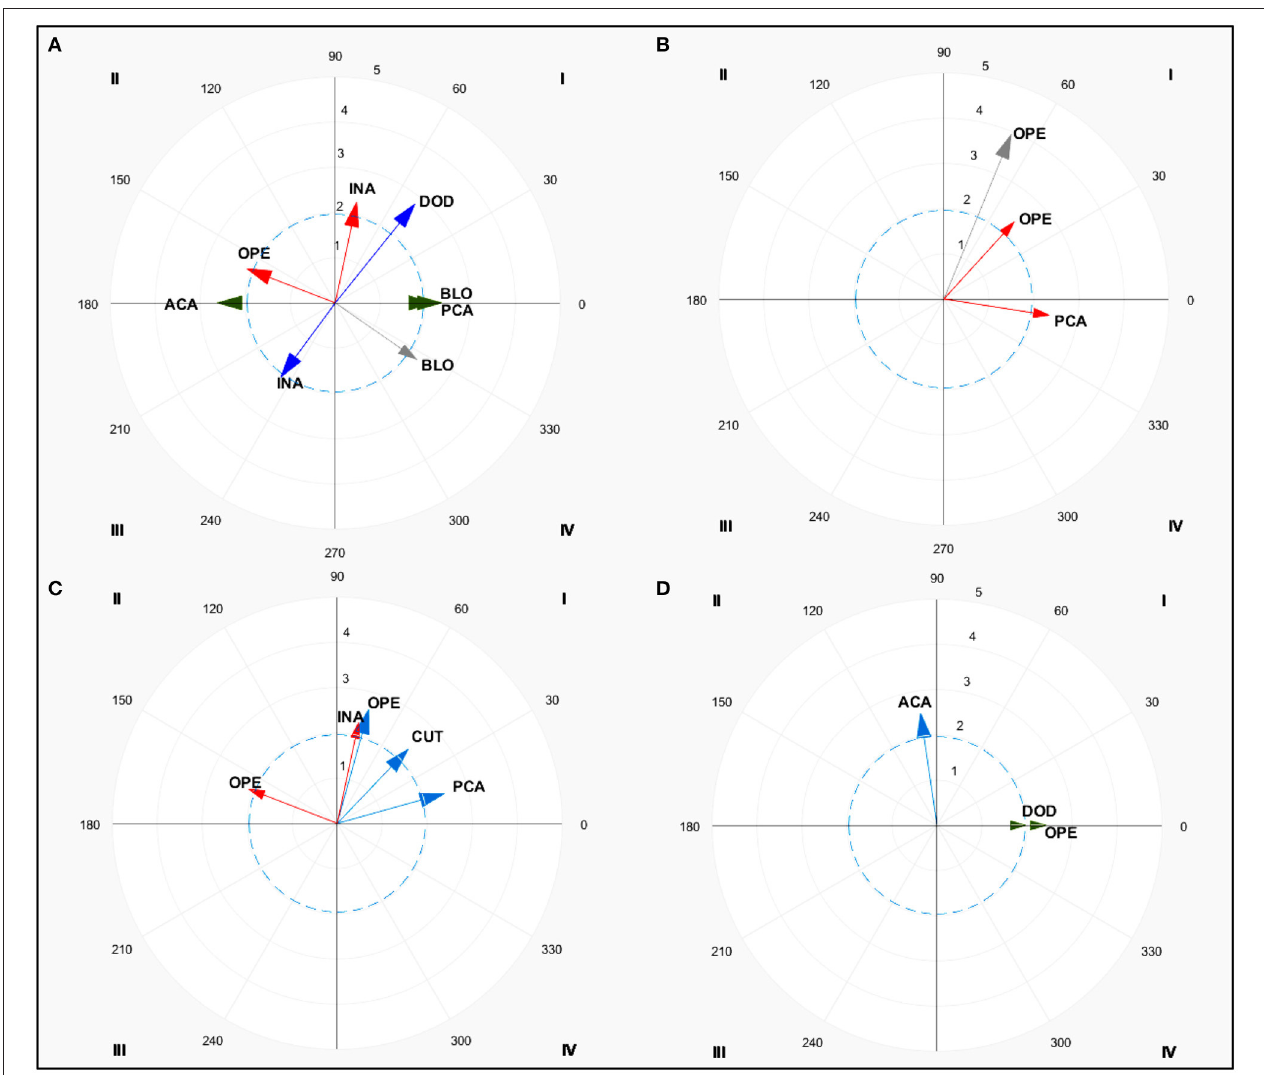
FIGURE 1 | Polar coordinate analysis of one-point (A) , two-point (B) , three-point (C) , and four-point (D) actions for females. Color arrows indicate significant relationships ( z > 1.96) in each weight category: fin (blue), feather (green), light (red), and gray (heavy). DIA, Direct Attack; INA, Indirect Attack; BLO, Blocks; DOD, Dodge; OPE, Opening; ACA, Anticipatory counterattack; SCA, Simultaneous counterattack; PCA, Posterior